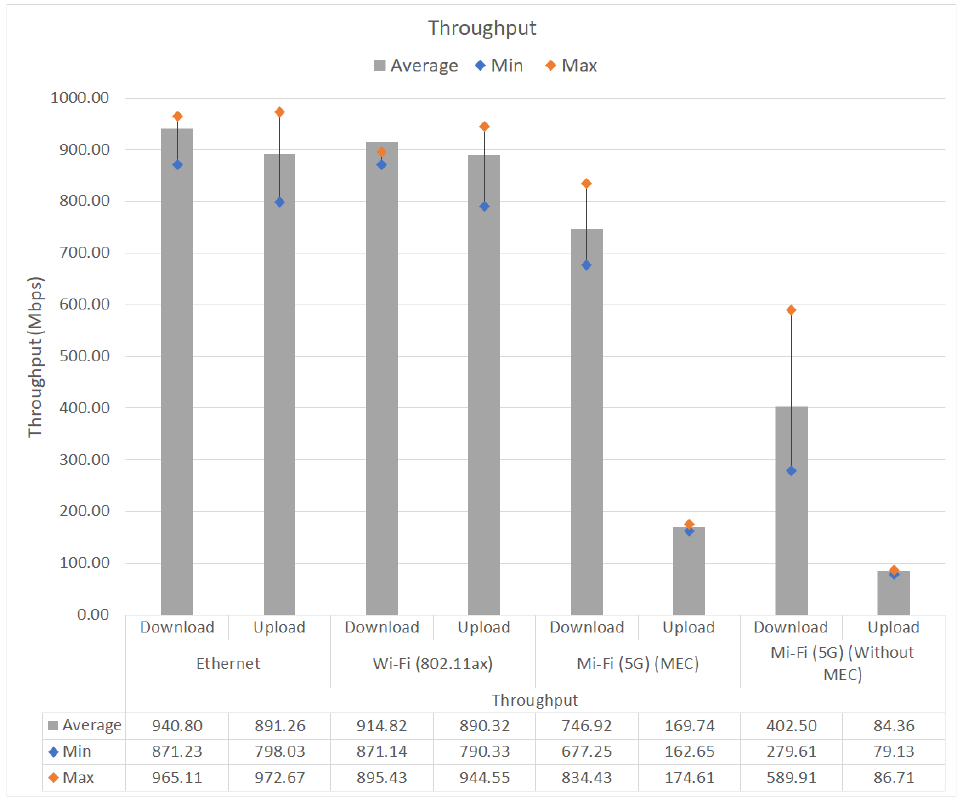
Figure 6. Multi-Access Edge Network Throughput.